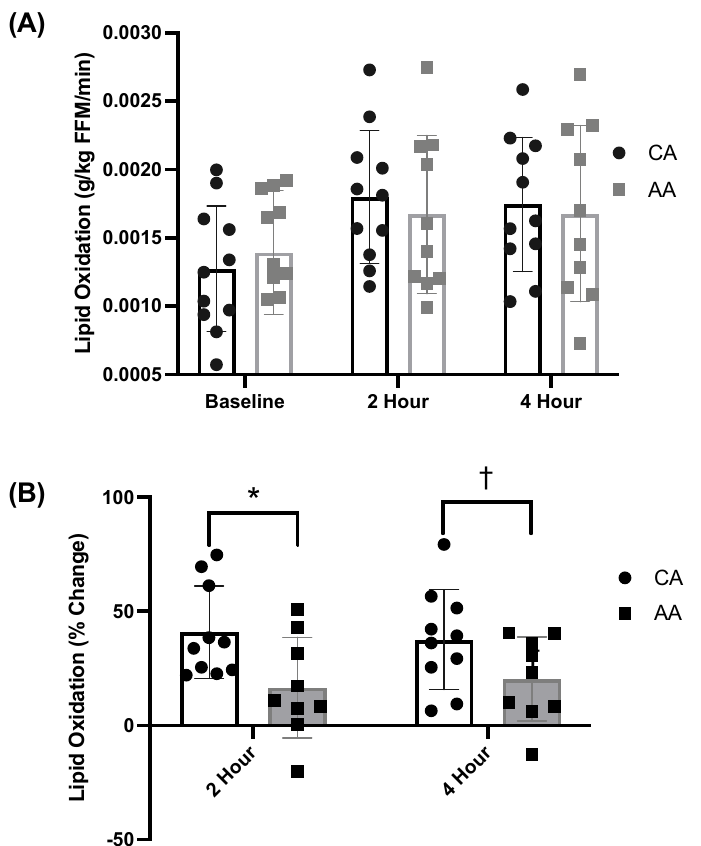
Figure 1. Baseline and postprandial fat oxidation and metabolic flexibly in response to a high-fat meal in African American and Caucasian American females. ( A ) Relative lipid oxidation (g/kg FFM/min; ANOVA: Time, p < 0.001, η p2 = 0.775; Group, p = 0.127, η p2 = 0.103; n = 23) response to a high-fat meal and ( B ) metabolic flexibility response to a high-fat meal (% change in lipid oxidation) at 2 and 4 h postprandial ( t -test; * p = 0.022 and † p = 0.081). AA—African American; CA—Caucasian American.